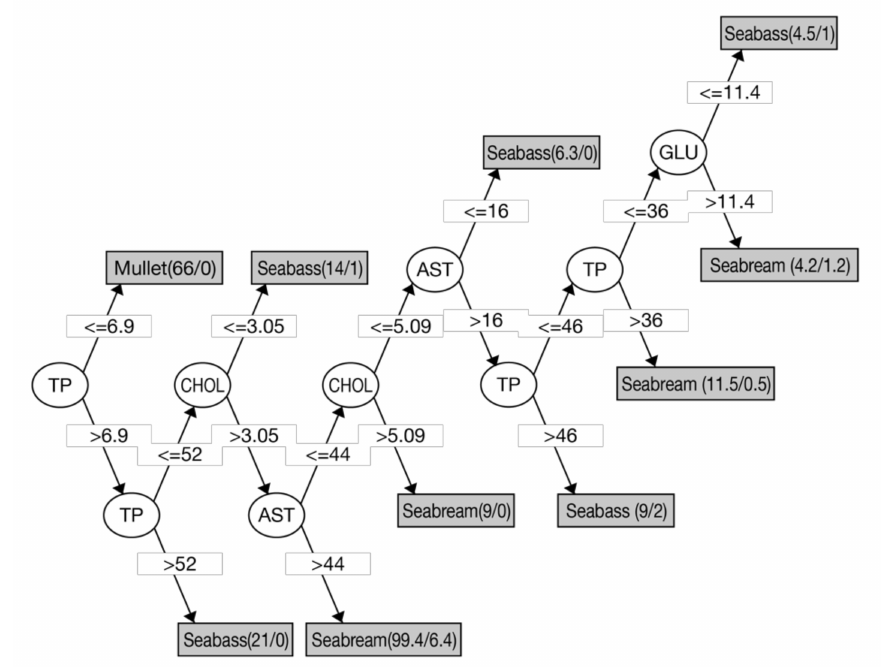
Figure 30. Decision-tree model based on biochemistry data for three fish species.